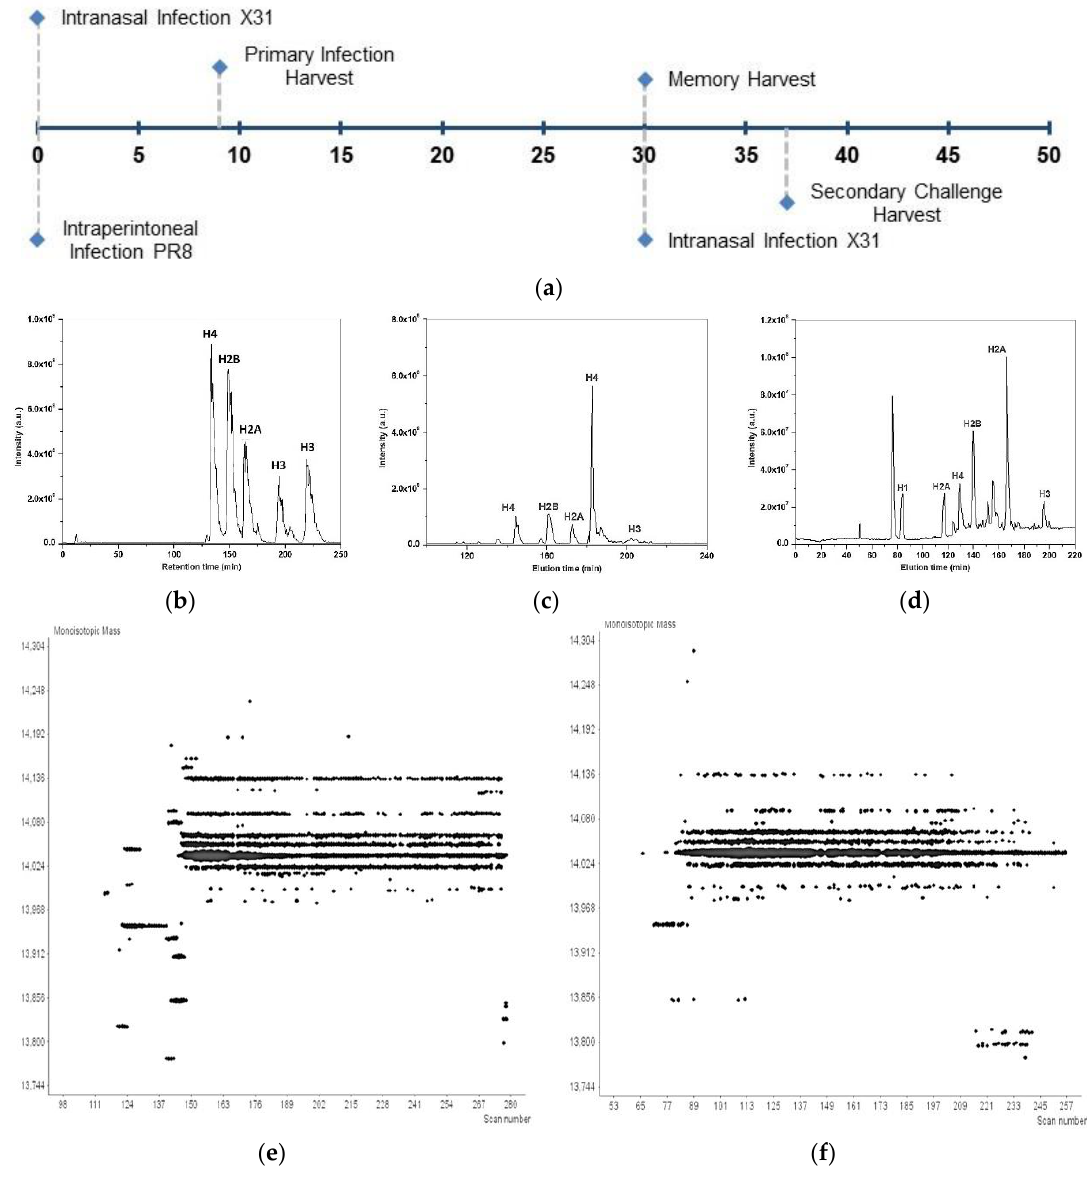
Figure 1. Representative mass spectral data of core histones from CD8 T cells. ( a ) Female C57BL/6 mice were used with 2 – 5, 10 – 15, or 1 – 2 mice per primary, memory, and secondary infection, respectively. Mice were intranasally infected with influenza A virus strain A/X-31(H3N2) (X31) at EID 50 of 10 6 and sacrificed on day 9 for the primary response or after 30 days for the memory response. For the secondary response, mice received intraperitoneal injections of PR8 at EID 50 of 10 8 and, after 30 days, were challenged with X31 as described above. These mice were sacrificed 7 days after the heterologous challenge. In the primary infection, bronchial lavage fluid (BAL) was taken from mice, lungs were profused then harvested, and spleens were harvested. Prior to sorting, crude cell preparations from mice were grouped, and contaminated immune cells were reduced by negative depletion. Enriched CD8 T cells were stained for surface markers and sorted by FACS. Naïve cells were selected based on CD8hi CD44low CD43low CD25low from the spleen in the primary. Activated T cells from the spleen were selected based on CD8hi CD44hi CD43hi CD25hi from the primary and secondary responses. Enriched Tm from the spleen were selected based on CD8hi CD44 + CD43 + . T cells from BAL were selected based on CD8 + CD44hi CD43hi + CD25 + and CD8 + CD44hi CD43hi CD25mid-hi from the lung. Histones were purified from T cell populations using a histone purification kit (Active Motif, Carlsbad, CA, USA) for purifying core histones while preserving modification states. Each